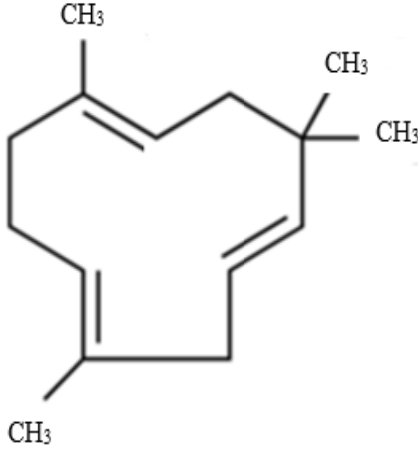
Figure 2. Chemical structure of α -humulene